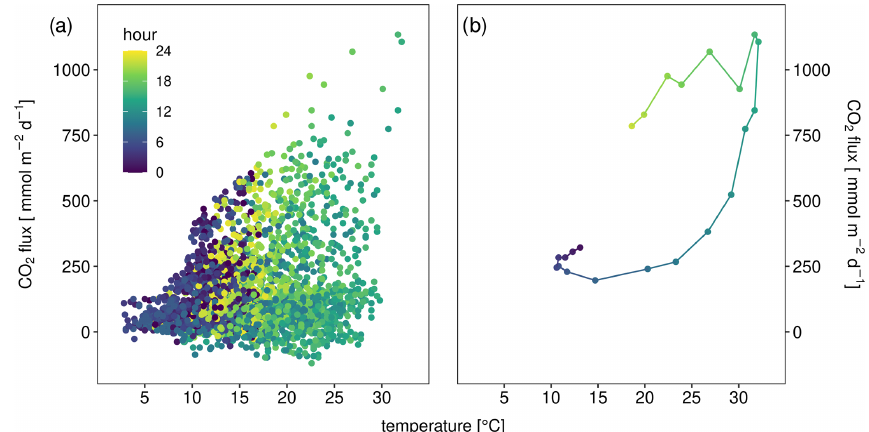
Figure 3. CO 2 flux in millimole per square meter per day (obtained from three automatic chambers) depending on sediment temperature of